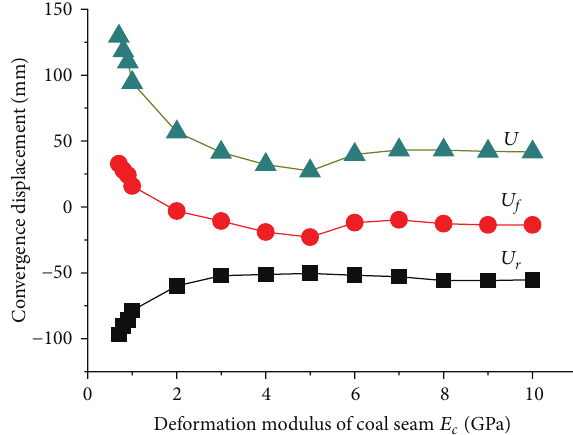
Figure 6: Changes of tunnel displacements with depth of coal seam under floor.